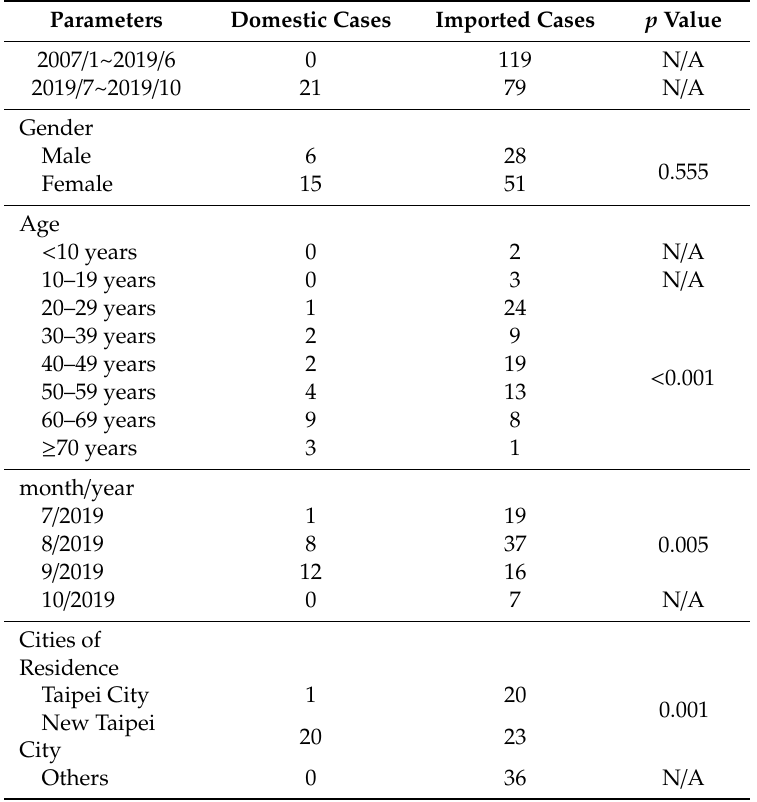
Table 1. Epidemiological features by examining chikungunya in domestic and imported cases. Parameters Domestic